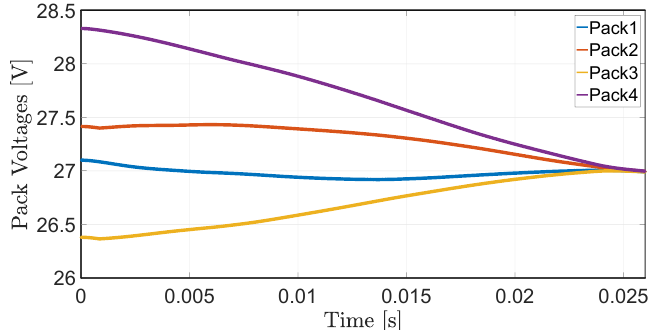
Figure 9. Battery packs’ (1–4) equalized voltages (with 0.5